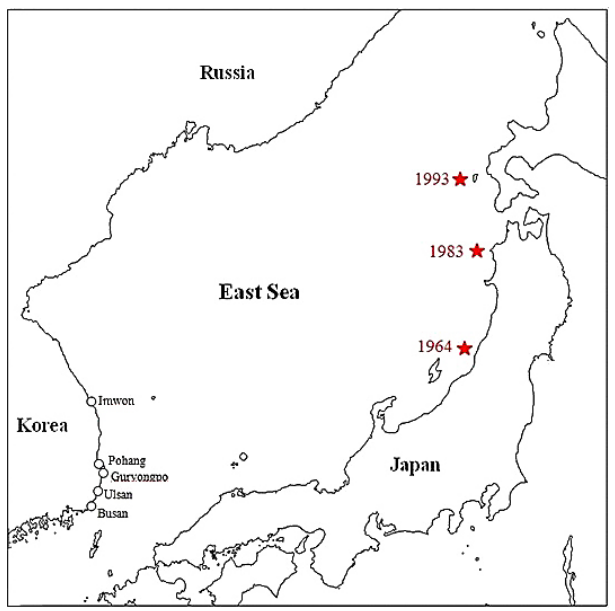
Figure 2. Predicted arrival time of leading tsunamis (unit: